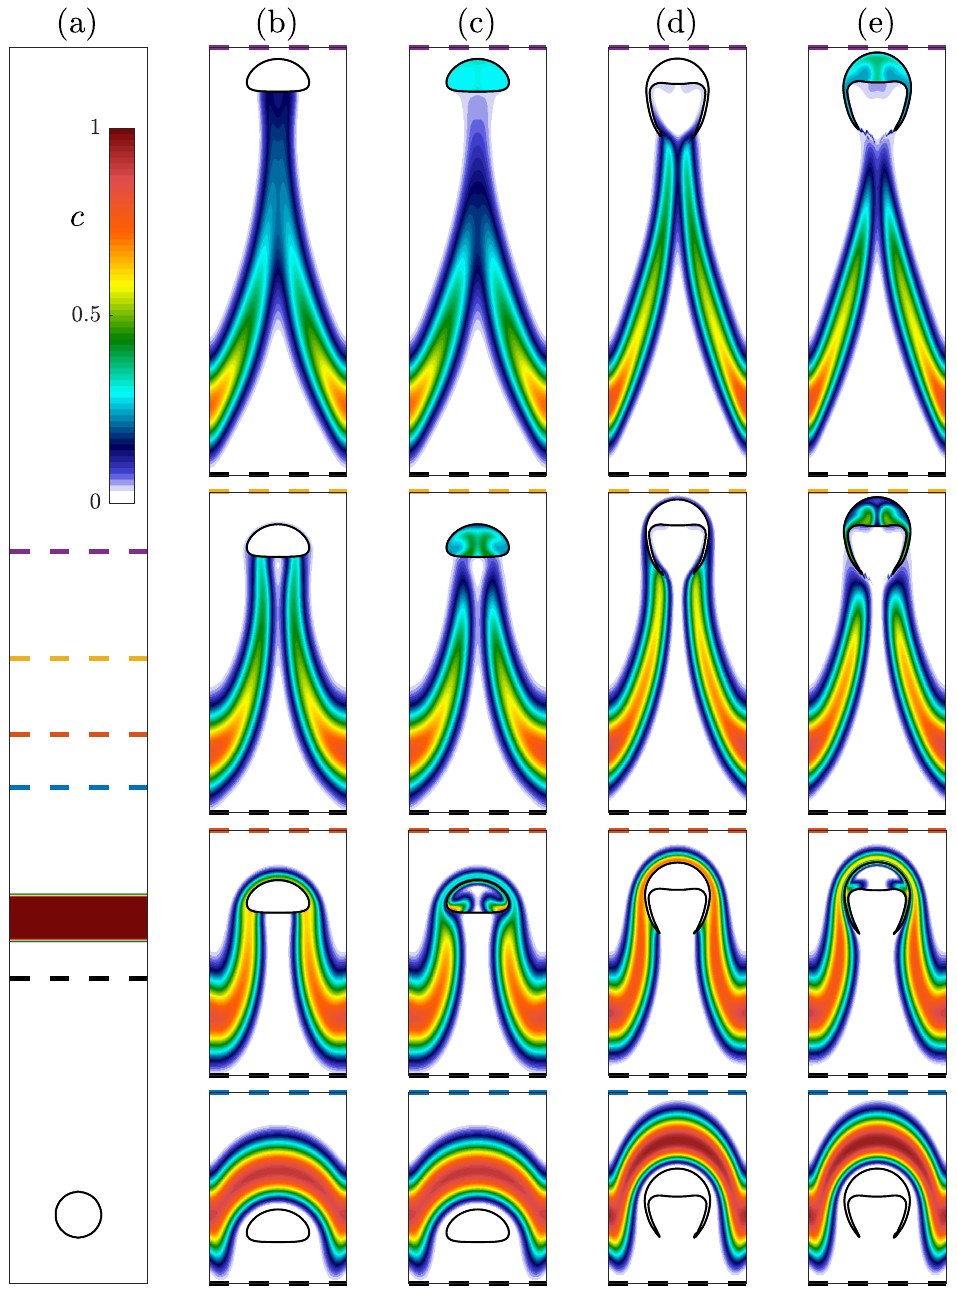
Figure 9. Evolution of four bubbles rising through a concentration layer. ( a ) The initial condition for all four simulations with a bubble containing c = 0 surrounded by liquid with c = 0 below a layer with c = 1. ( b , c ) Spherical and ( d , e ) skirted bubbles are allowed to rise through the concentration layer. Results for He = 0.01 are presented in ( b , d ) while He = 33 is presented in ( c , e ). Four different time instances with vertical ranges with the bottom of the range being the black dashed line and the top of each image corresponding to the blue, orange, yellow, and purple dashed lines in ( a